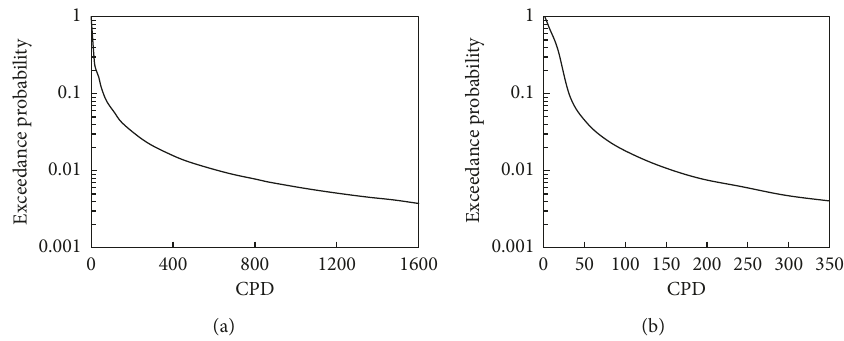
Figure 16: PSDC of the HPBRB ductility: (a) near-fault ground motion group; (b) far-fault ground motion group.